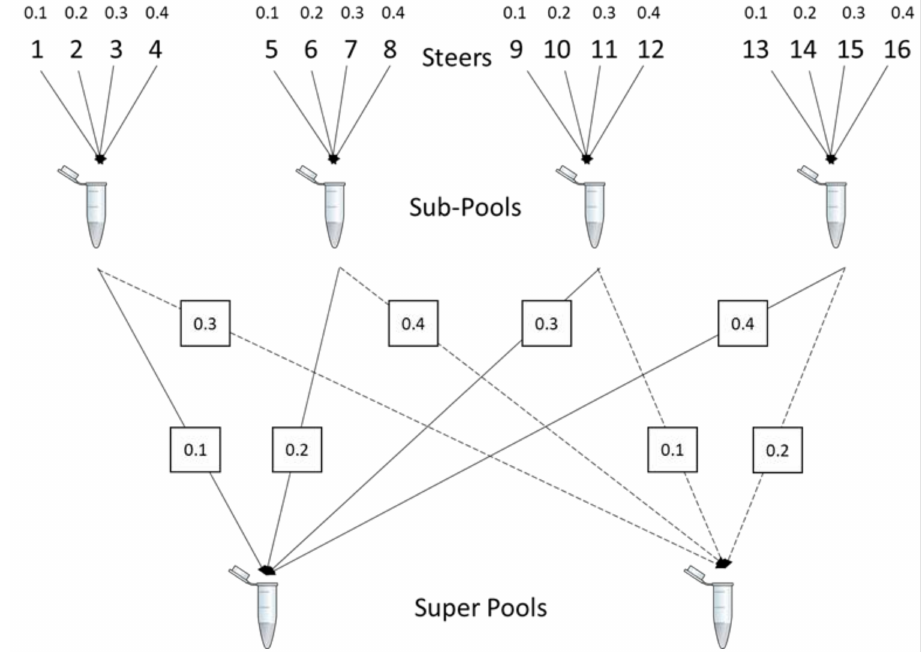
Figure 1. Graphical representation of the designed relative proportions of liver tissue from individual animals used to form sub-pools and DNA proportions used to form super pools. This design was replicated across two different liver phenotypes, abscessed and normal, to use a total of 32 ani- mal samples. Planned contributions of animals to sub-pools ranged for 10 to 40 % and animal contributions to super pools ranged from 1 to 16 % (Table